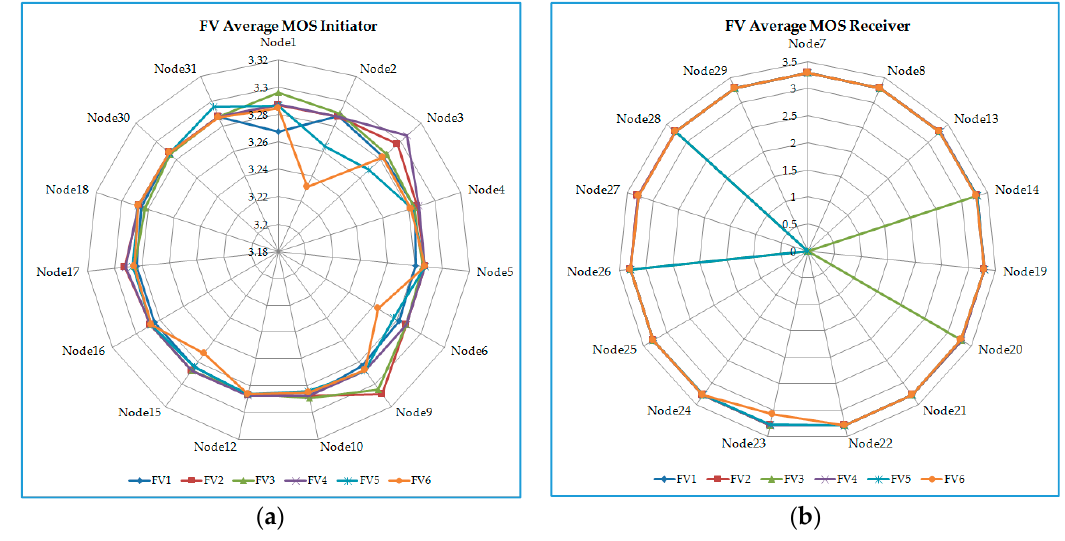
Figure 10. Flooded village MOS values for VoIP initiators and receivers: ( a ) VoIP initiators; ( b ) VoIP receivers.